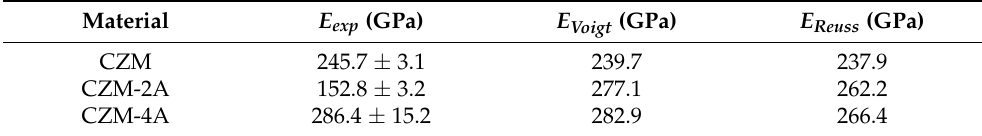
Table 4. Elastic modulus of the